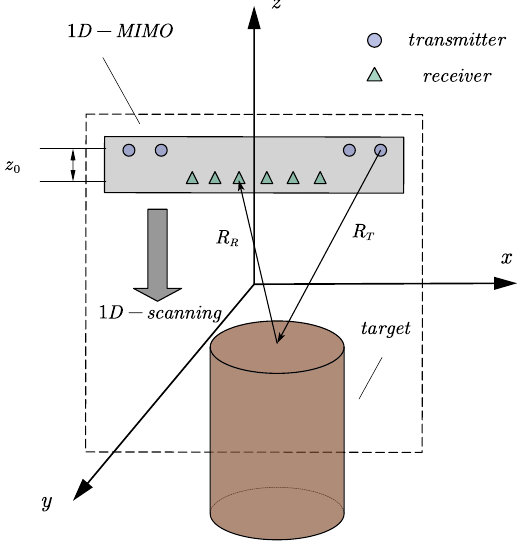
Figure 3. Geometry and coordinate definitions.